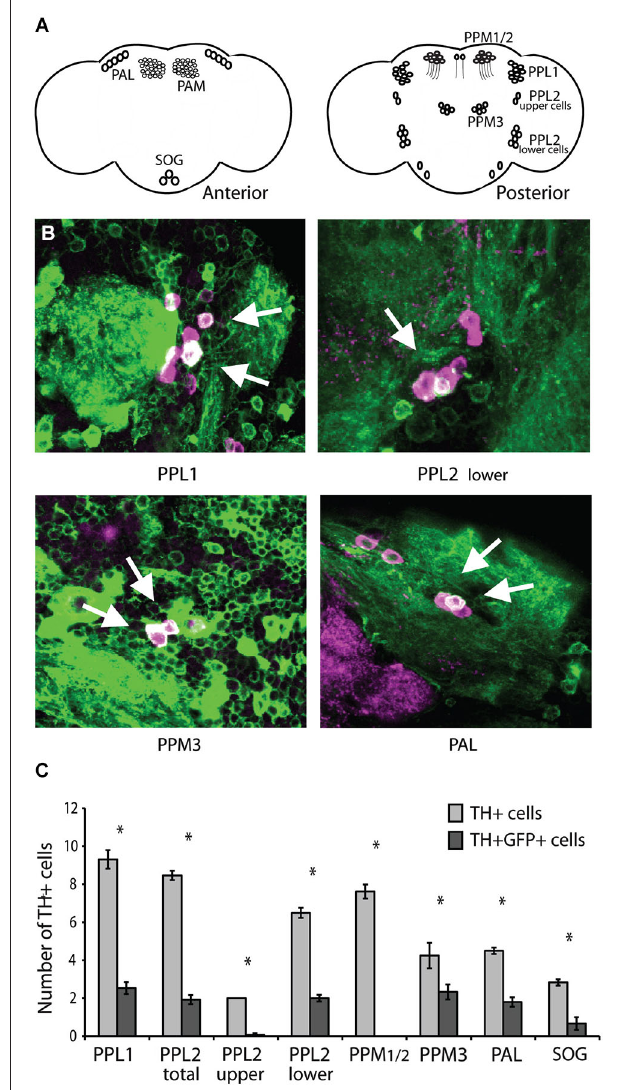
FIGURE 1 | C164-Gal4 expresses in dopaminergic neurons. (A) Dopaminergic neurons in the Drosophila brain are organized into distinct clusters (Mao and Davis, 2009). Left panel shows anterior brain clusters. Right panel shows clusters in the posterior brain. (B) The C164-Gal4 expression pattern visualized by crossing the GAL4 line to UAS-mCD8GFP . Brains were co-stained with anti-TH (shown in purple) to reveal dopaminergic neurons, while visualization of GFP expression was enhanced with an anti-GFP antibody (shown in green). The two staining patterns are presented as an overlay, and the arrows indicate points of overlap between the two expression patterns. (C) The number of TH+ and TH+GFP+ double positive cells in each dopaminergic neuron cluster were counted. The C164-Gal4 driver expresses in specific cells within the PAL, PPL1, PPL2, and PPM3 clusters. Significant differences between TH+ and TH+GFP+ double positive staining are represented by asterisks ( P < 0.05, Student’s t -test). See Section Methods for details on statistical